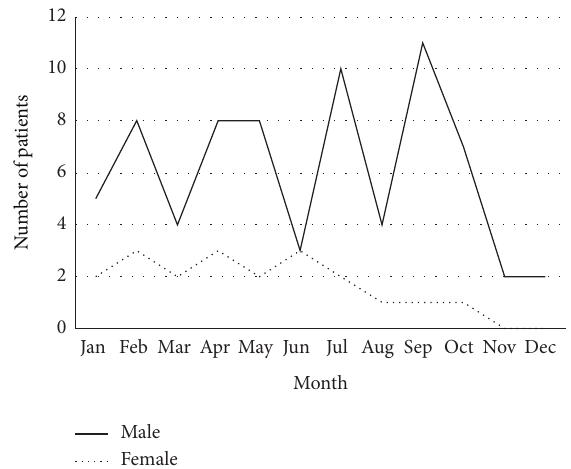
Figure 1: Incidence of traffic-related open globe injury by gender and month of a year.